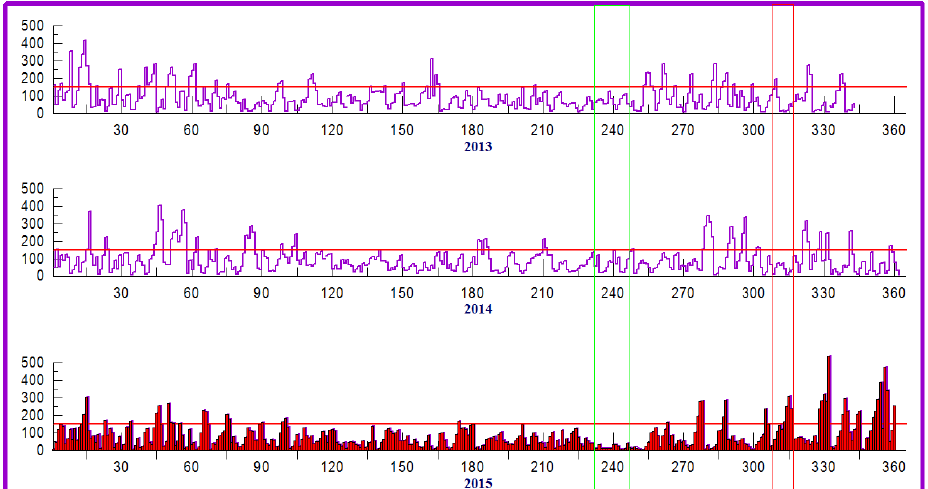
Figure 8. Daily mean value of PM 2.5 in monitoring sites of the Olympic Center from 2013 to 2015. Notes: The unit on the y -axis is μ g·m − 3 . The vertical green line and red line show the comparison over the same period when the 2015 Military Parade and 2014 APEC for three years from 2013 to 2015, respectively. The transverse red line shows the concentration of PM 2.5 is 115 μ g·m − 3 . Table 3. Changes in AQI over the same period from 2013 to 2015 during the Military Parade.